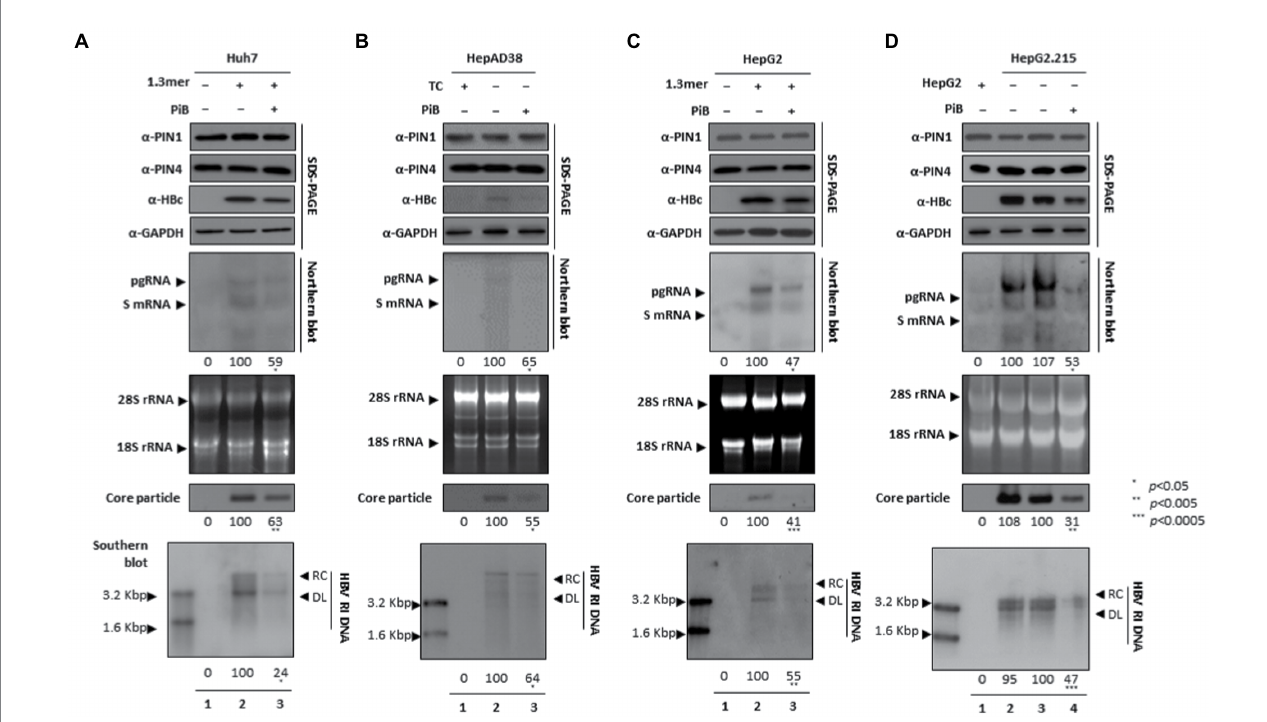
FIGURE 4 PiB-mediated inhibition of PIN1 and PIN4 reduces HBV replication in Huh7, HepAD38, HepG2, and HepG2.2.15. (A–D) PiB reduces HBV replication. (A) The Huh7 cells were mock-transfected (lane 1), transfected with 4 μ g of 1.3 mer HBV WT and treated with DMSO (lane 2), or transfected by 1.3 mer HBV WT (4 μ g) and treated with 20 μ M of PiB for 72 h (lane 3). (B) HepAD38 was treated with mock (none, lane 1) or DMSO (lane 2), or treated with 20 μ M PiB (lane 3) for 72 h. (C) HepG2 cells were transfected with mock (lane 1), or 1.3 mer HBV WT (4 μ g) transfected and treated with DMSO (lane 2), or 4 μ g 1.3 mer HBV WT transfected and treated with PiB (20 μ M) for 72 h (lane 3). (D) HepG2.2.15 cells were treated with mock (none, lane 2) or treated DMSO (lane 3) or PiB (20 μ M) treated for 72 h (lane 4). Lane 1 indicates mock-transfected HepG2 cells (negative control). The lysates were subjected to SDS-PAGE and immunoblotting, NAGE, Northern, and Southern blotting, as described previously (Piracha et al., 2018). The presented data are representative of three independent experiments. The statistical analysis was determined using Student’s t -test. * p < 0.05, ** p < 0.005, *** p < 0.0005 relative to the